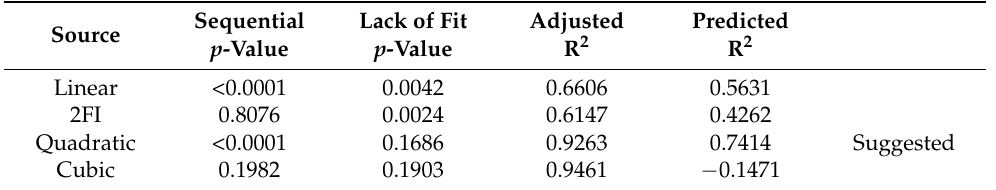
Table 5. Summary of quadratic model on the response ( Y 1 ) : TDS removal.